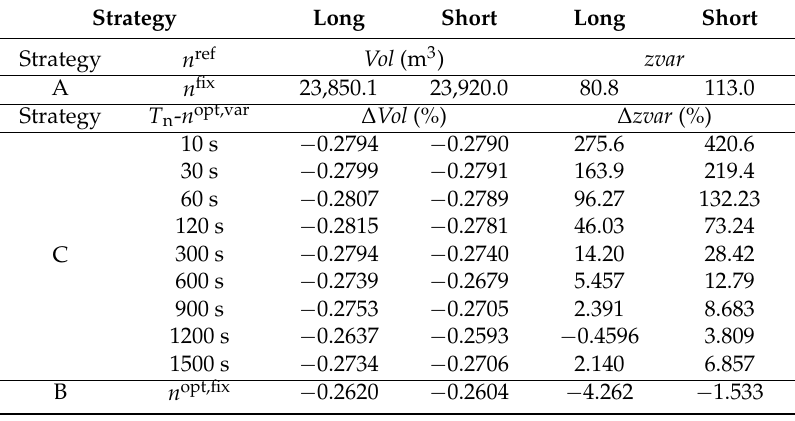
Table 5. Vol and zvar with the three control strategies and different update periods for the strategy C, n fix = 1.0508